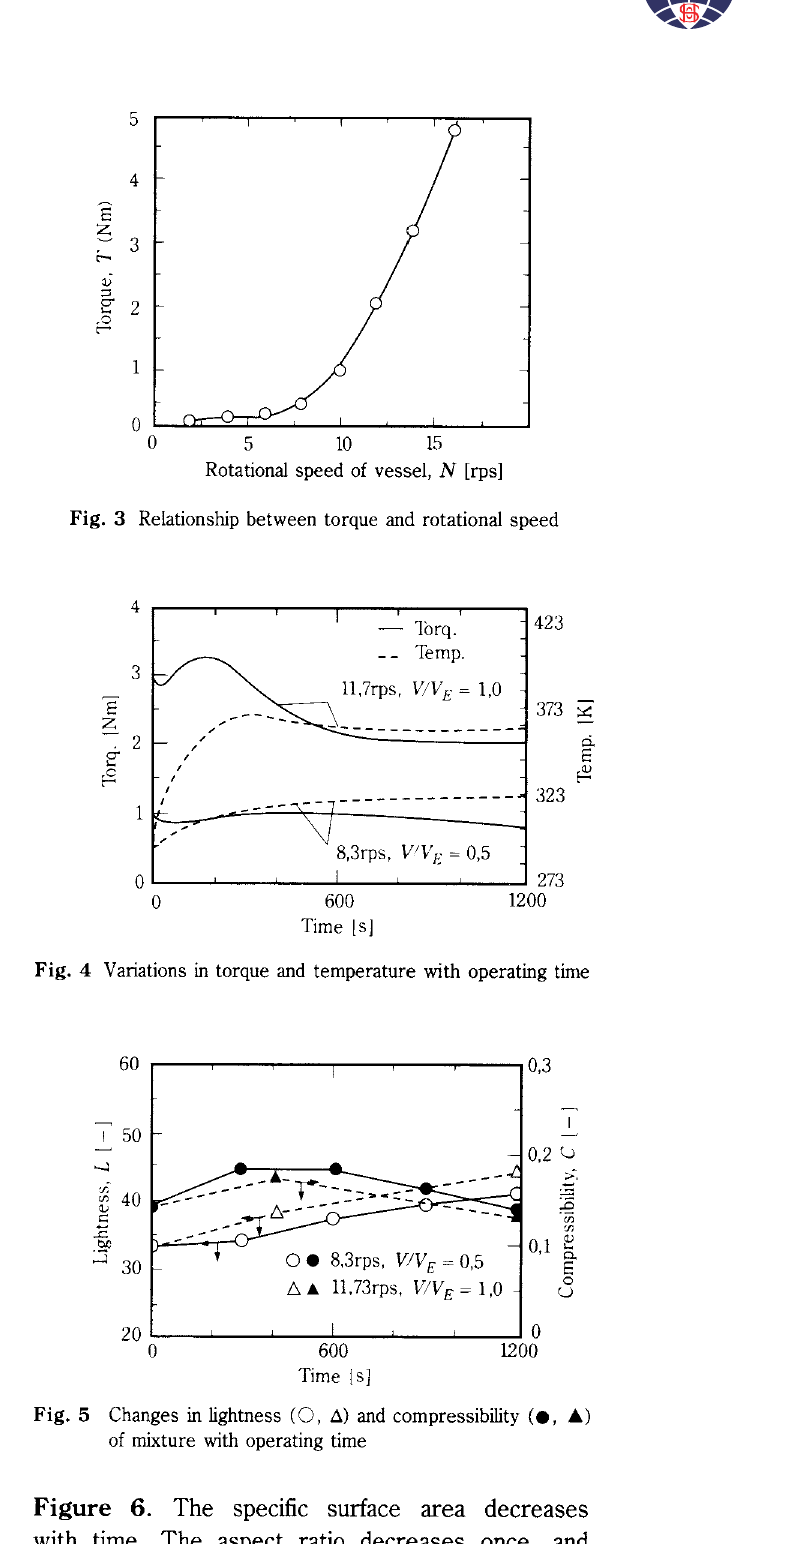
Fig. 5 Changes in lightness (0, ~)and compressibility (e, A) of mixture with operating time Figure 6. The specific surface area decreases with time. The aspect ratio decreases once, and then, increases again. This result shows the deforma tion process of the matrix particles by high-shear and high-stress during the compounding operation, i.e. in the initial stage, flattened elliptic particles are transformed into spheres by a sort of knead ing effects accompanying the rolling and folding mechanisms without breaking into fine